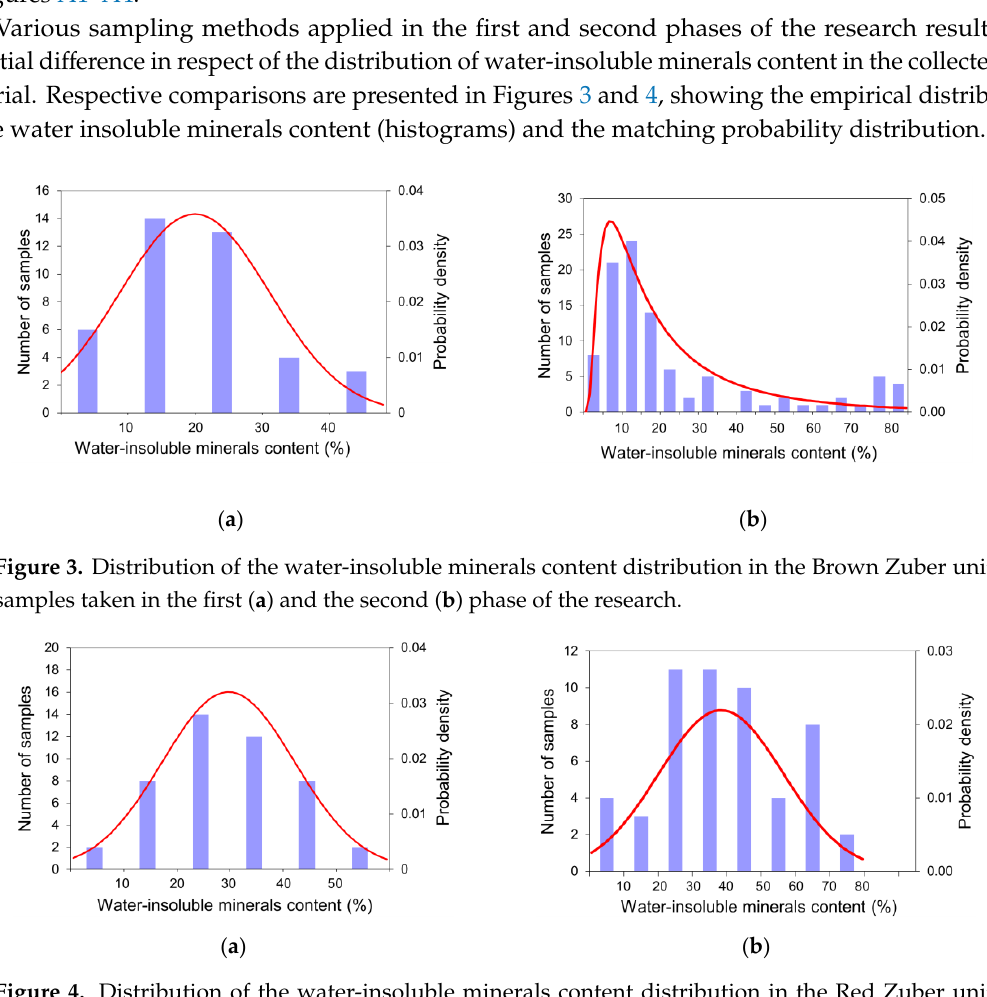
Figure 4. Distribution of the water-insoluble minerals content distribution in the Red Zuber unit samples taken in the first ( a ) and the second ( b ) phase of the research.